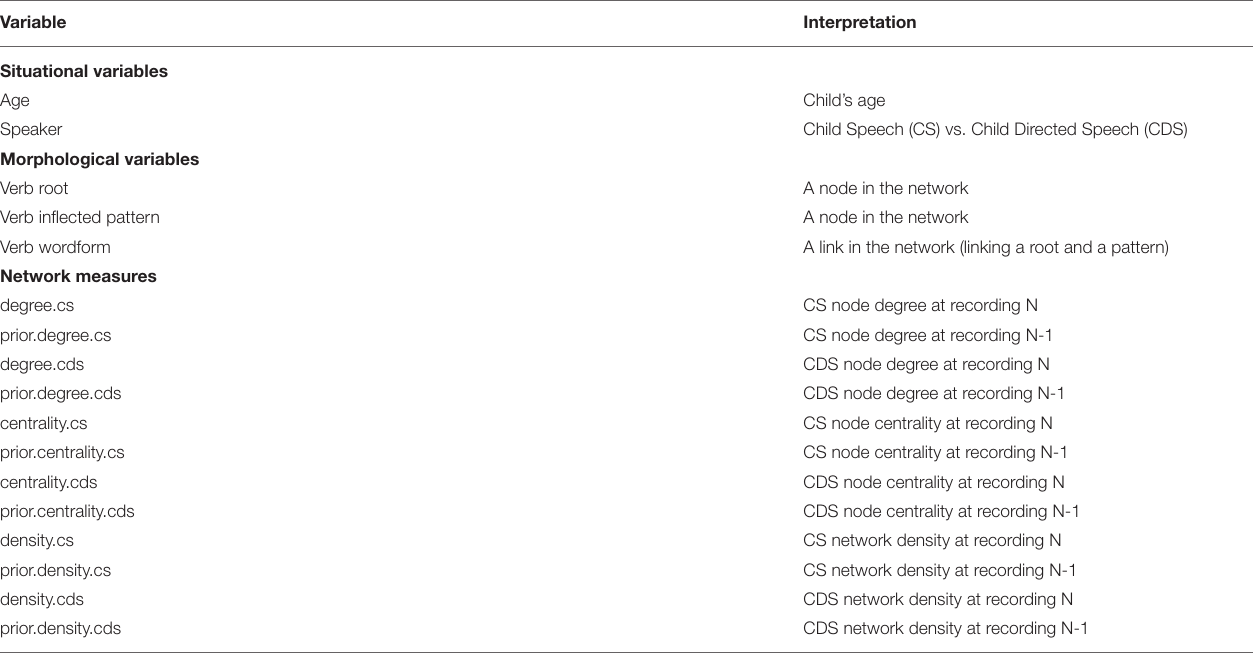
TABLE 5 | Summary of study